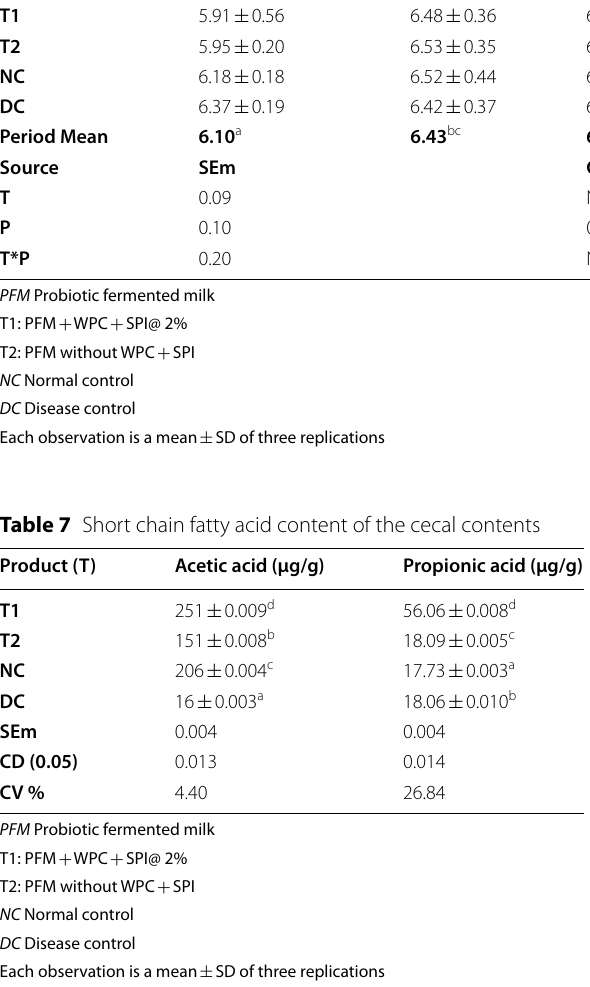
Table 6 Evaluation of Coliform count (log cfu/ml) of fecal matter